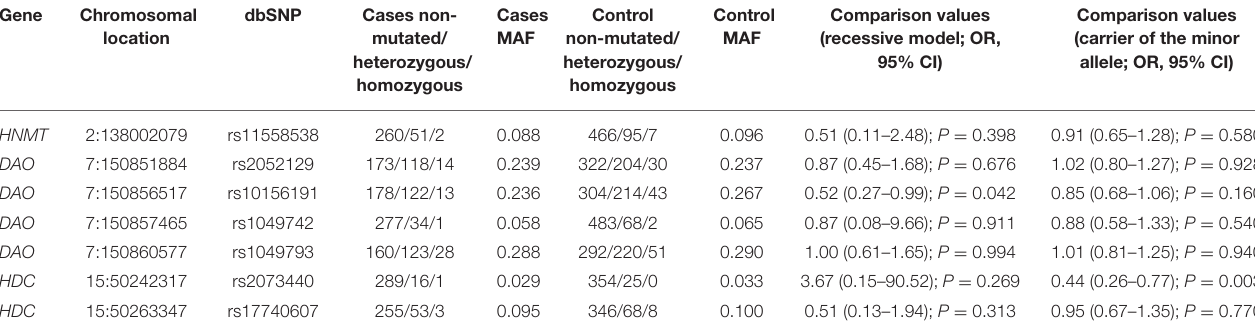
Comparison values (carrier of the minor allele; OR, 95% CI)